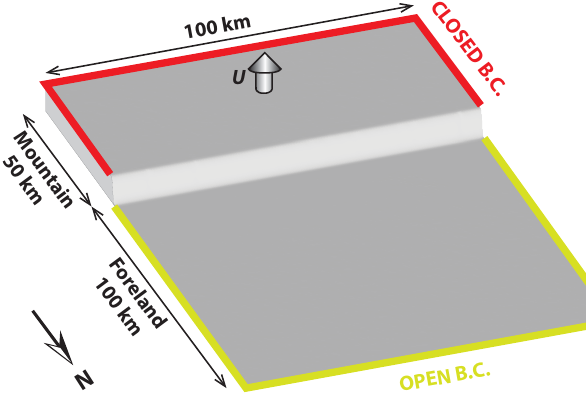
Figure 2. The model grid consists of a mountain section, subjected to constant uplift U , and of a flat foreland section; both sections are subjected to precipitation. B.C. is boundary conditions; neither wa- ter nor sediment can cross a closed B.C., while an open B.C. corre- sponds to transverse rivers of fixed elevation capable of transporting both sediment and water fluxes out of the